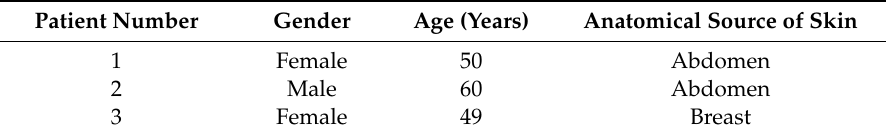
Table 2. Demographic data and source of explants.